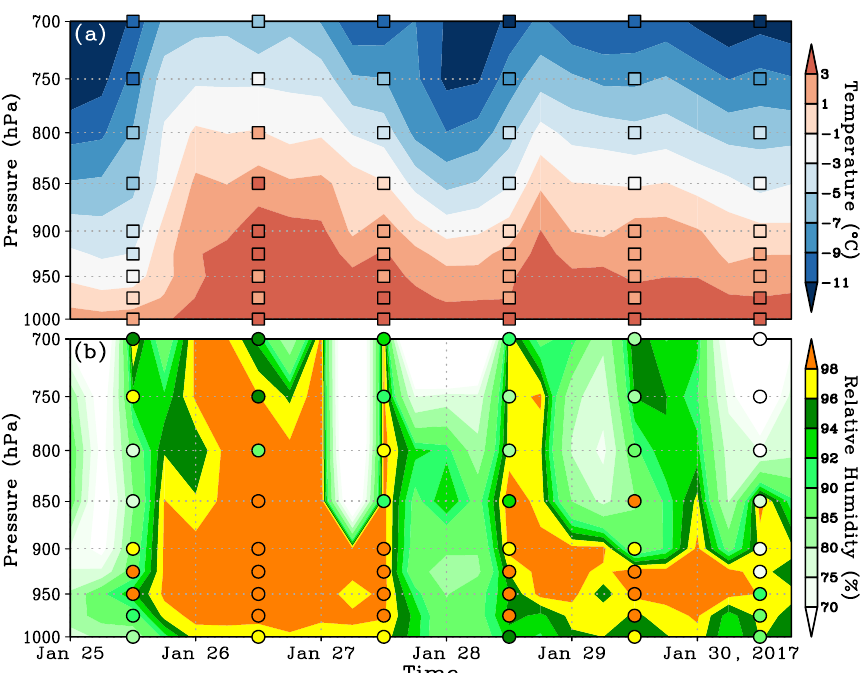
Figure 6. Time series of analysis data and in situ observations of temperature ( a ) and relative humidity ( b ) at different pressure levels near King George Island. The square and circle represent in situ observed temperatures and relative humidity values, respectively.